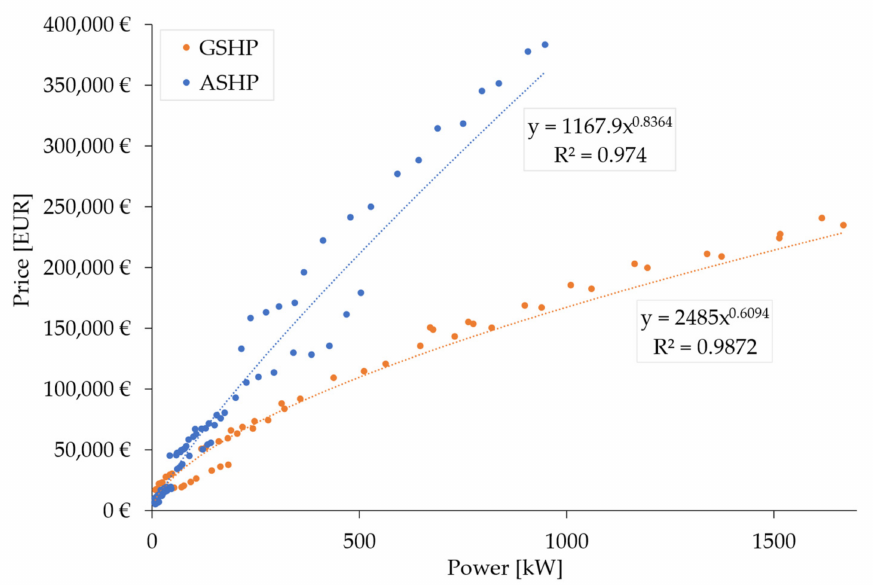
Figure 3. Correlations between capacity and cost for air- and ground-source heat pumps (elaboration from Refs.